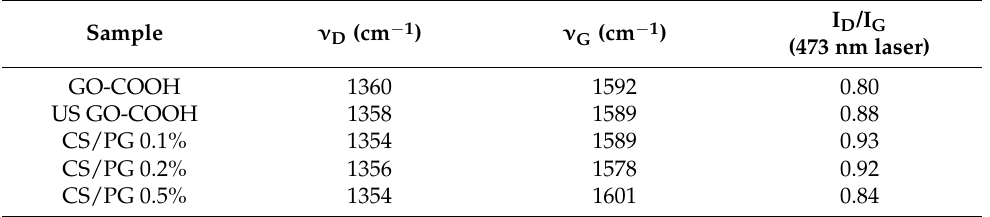
Figure 3. Raman spectra of GO-COOH and GO-COOH subjected to ultrasonication (US) treatment and CS/PG composite nanofibrous scaffolds with varying GO-COOH content. Table 3. The I D /I G ratio of GO-COOH and GO-COOH subjected to ultrasonication (US) treatment, and CS/PG composite nanofibrous scaffolds from Raman